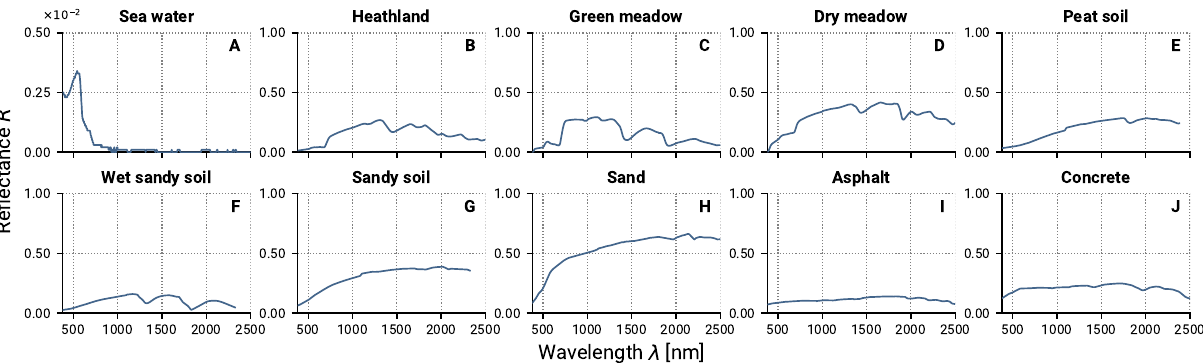
Figure 4. In situ measured reflectance spectra of environmental surfaces used for layered spectral mixture after ( A ) Siegert et al. [39], ( B , H ) Neumann et al. [40], ( C , D ) Roessner et al. [41], ( E ) Blasch et al. [42], ( F , G ) Spengler [43], and ( I , J ) Bochow [44]. The y-axis scaling of ( A ) differs to that of the other spectra, as water absorbs nearly all energy in this wavelength range. Both sandy soil surfaces ( F , G ) were measured up to 2450nm